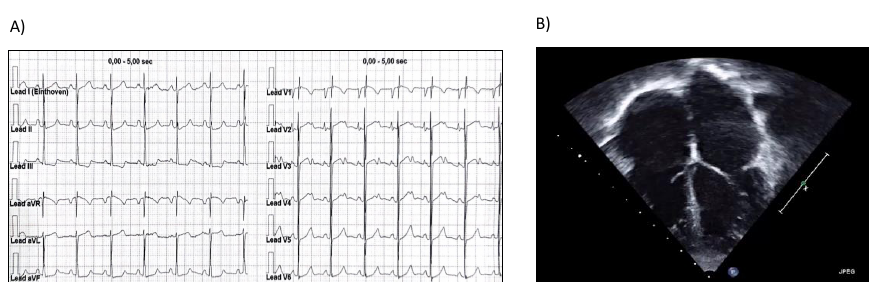
Figure 1. Proband’s instrumental evaluation (EGG and echocardiogram). ( A ) ECG shows normal sinus rhythm, bi-atrial enlargement and ST segment depression in inferior leads. ( B ) Echocardiogram shows an RCM: bi-atrial enlargement and normal ventricular volume.